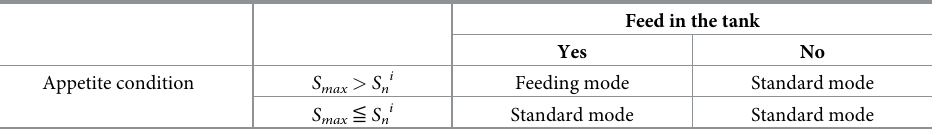
Standard mode Standard